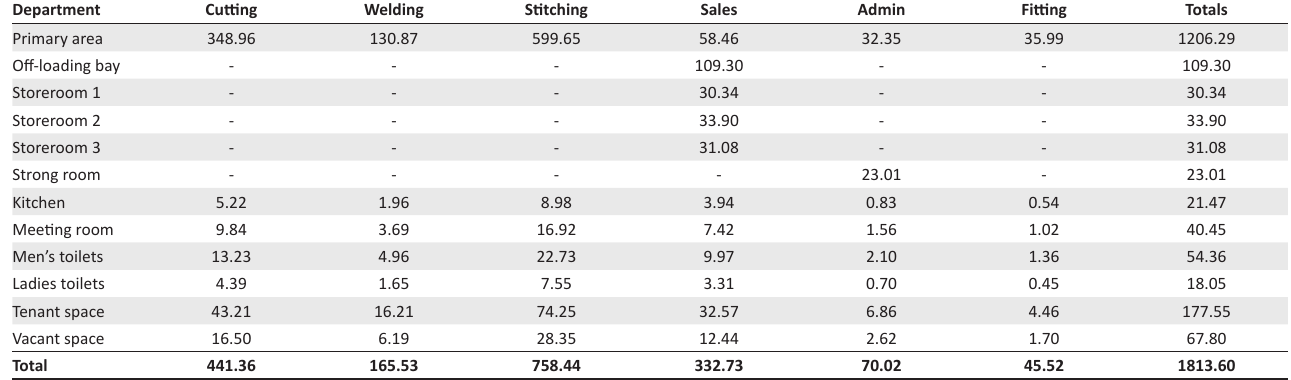
TABLE 3: Floor space allocation matrix (presented in m 2 ).